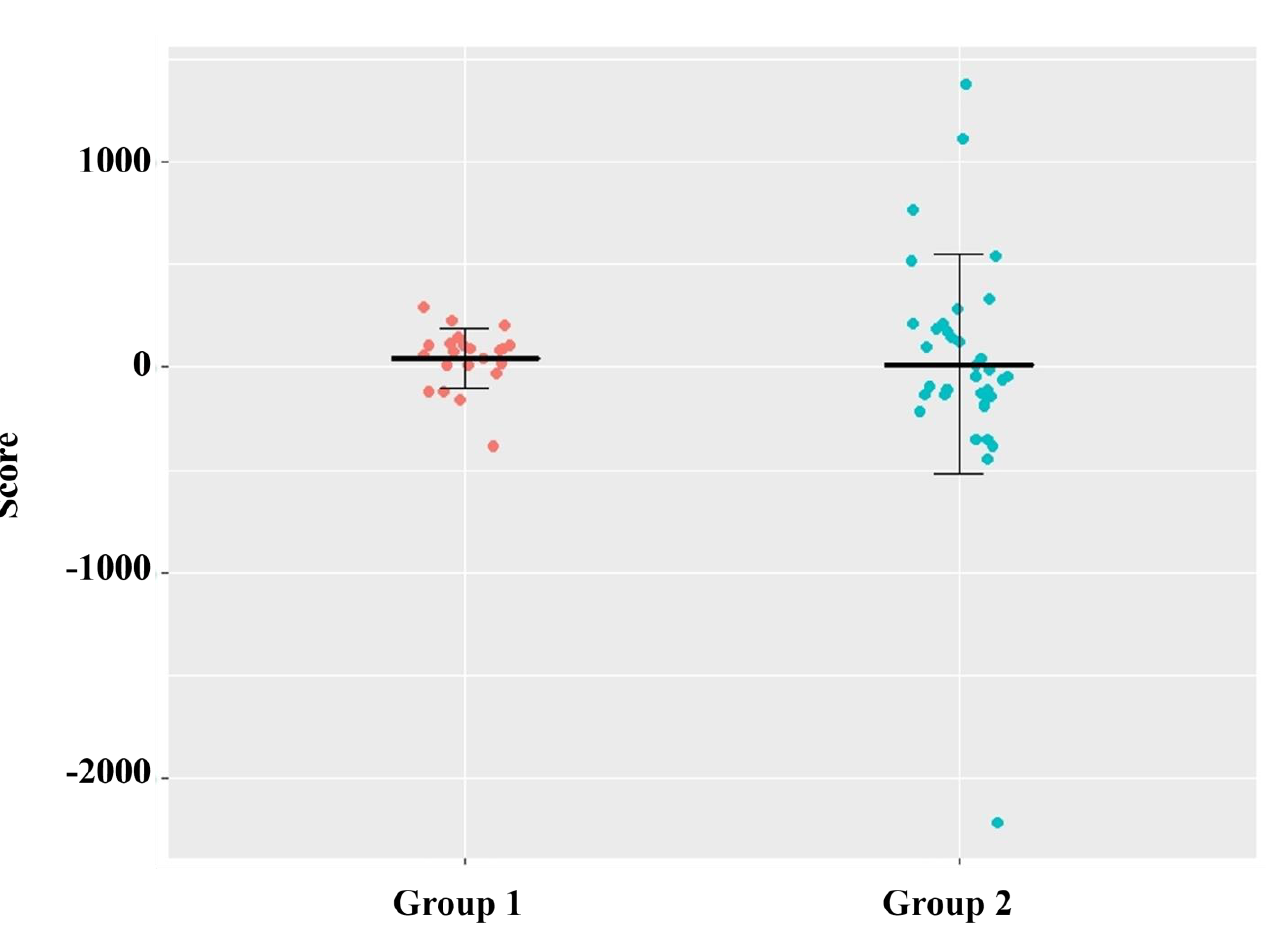
Figure 3. NMR data dotplot of Mahalanobis’ distance to the centers of groups separated by i-means. Score indicates Mahalanobis’ distance of the group classified by the i-means method. Dots indicate scores for individual samples, and the central horizontal line indicates the mean. The short vertical line represents the range of ± 1 standard deviation. It can be seen that some data deviate from the average.